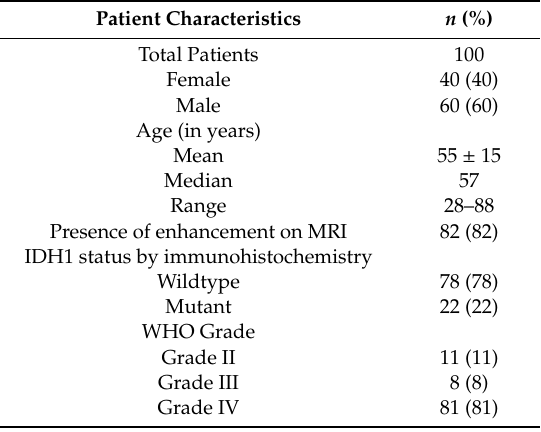
Table 1. Patient